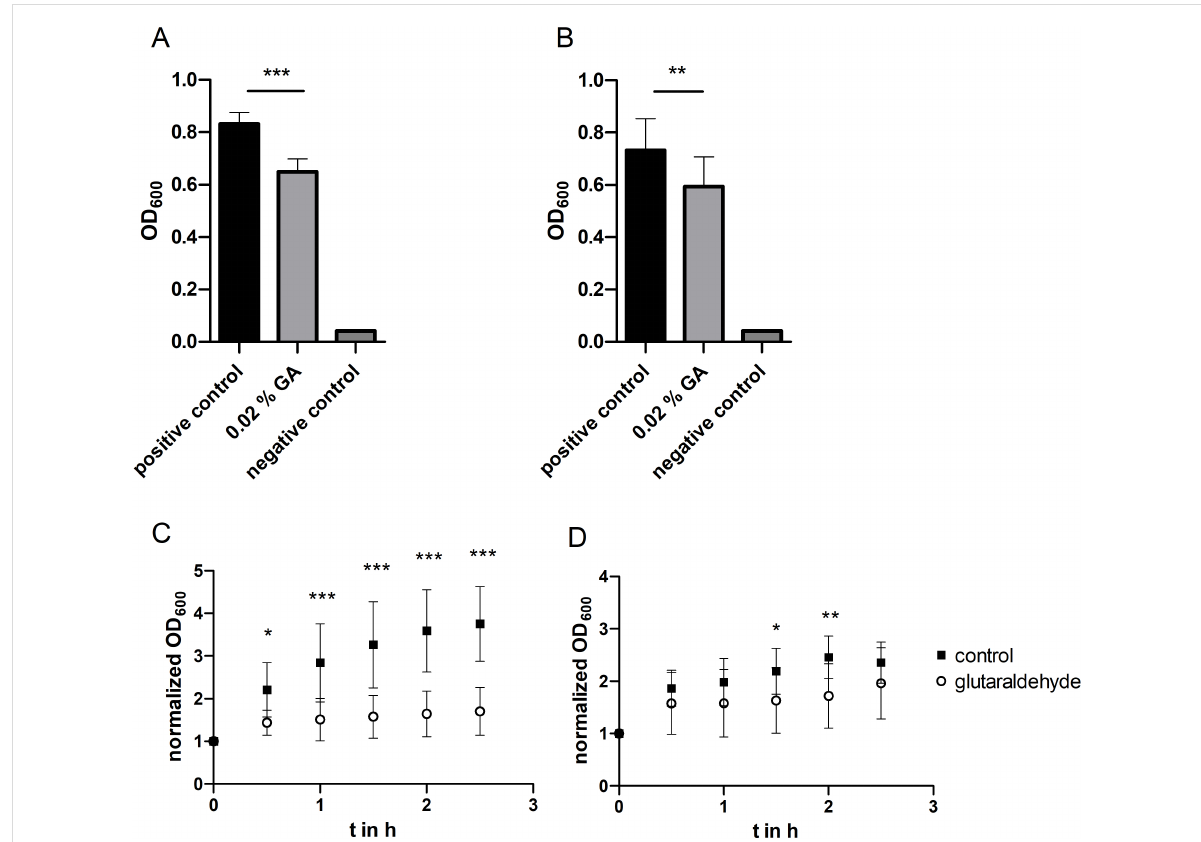
Figure 2: Effect of glutaraldehyde on bacterial growth of E. coli and S. epidermidis . E. coli (A) and S. epidermidis (B) cells were incubated for 20 h at 37 °C in Mueller–Hinton II Bouillon (positive control), Mueller–Hinton II Bouillon + 0.02% GA, or Mueller–Hinton II Bouillon + 0.4% peracetic acid (negative control). Error bars represent standard deviation (SD, n = 12 biological replicates). The statistical analysis was performed by one-way ANOVA with Bonferroni’s multiple comparison test, SD for negative controls <0.0015. E. coli (C) and S. epidermidis (D) cells were preincubated for 20 h at 37 °C in Mueller–Hinton II Bouillon. Afterwards the growth medium was removed and replaced with fresh Mueller–Hinton II Bouillon (“control”) or Mueller–Hinton II Bouillon + 0.02% GA (“glutaraldehyde”). Cells were grown for 2.5 h at room temperature. Error bars are SD ( n = 12 biological replicates). Statistical analysis was performed by a two-way ANOVA with Bonferroni’s multiple comparison test; * corresponds to p < 0.05; ** corre- sponds to p < 0.01; *** corresponds to p < 0.001.